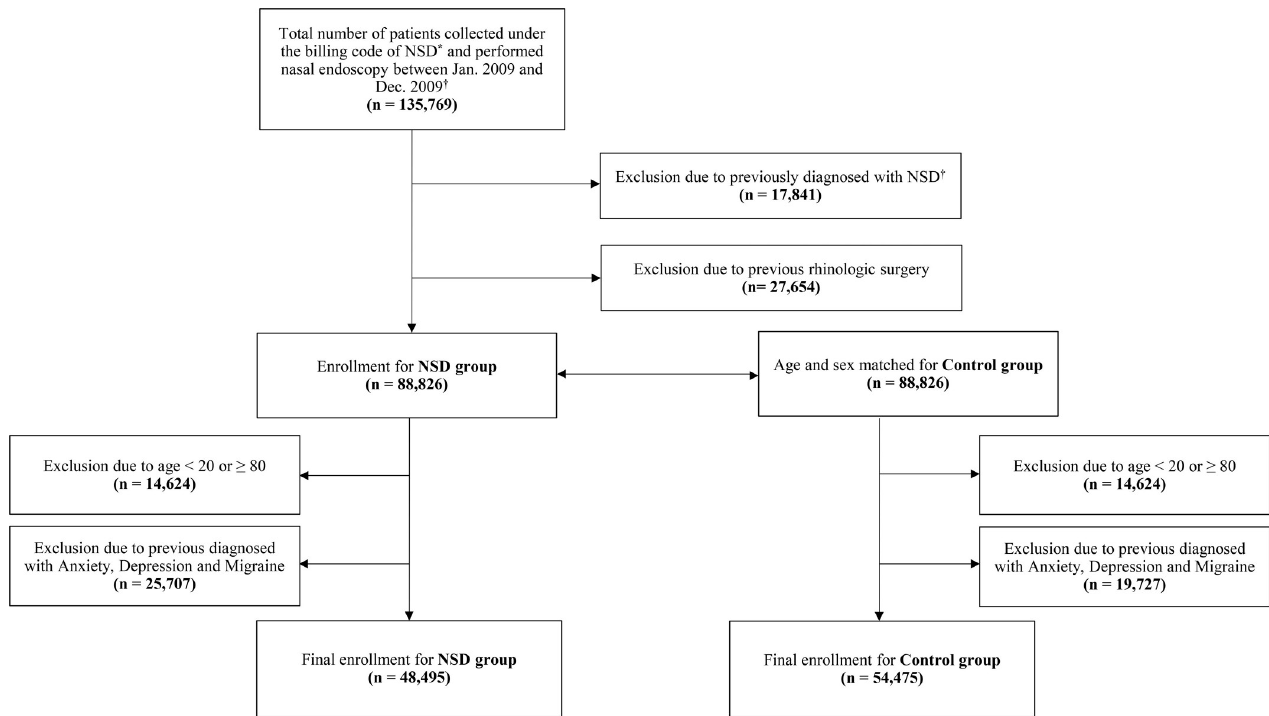
Fig 1. A schematic flow diagram of the subject selection in the present study. Of 135,769 patients diagnosed with NSD in 2009, 88,826 patients were selected. Participants with previous NSD and rhinologic surgery were excluded. NSD participants were matched with a control group who had not been diagnosed with NSD. Participants under 20 years of age or over 80 years of age and previous psychoneurological disorders were also excluded. Finally, 48,495 participants with NSD and 54,475 control participants were included.